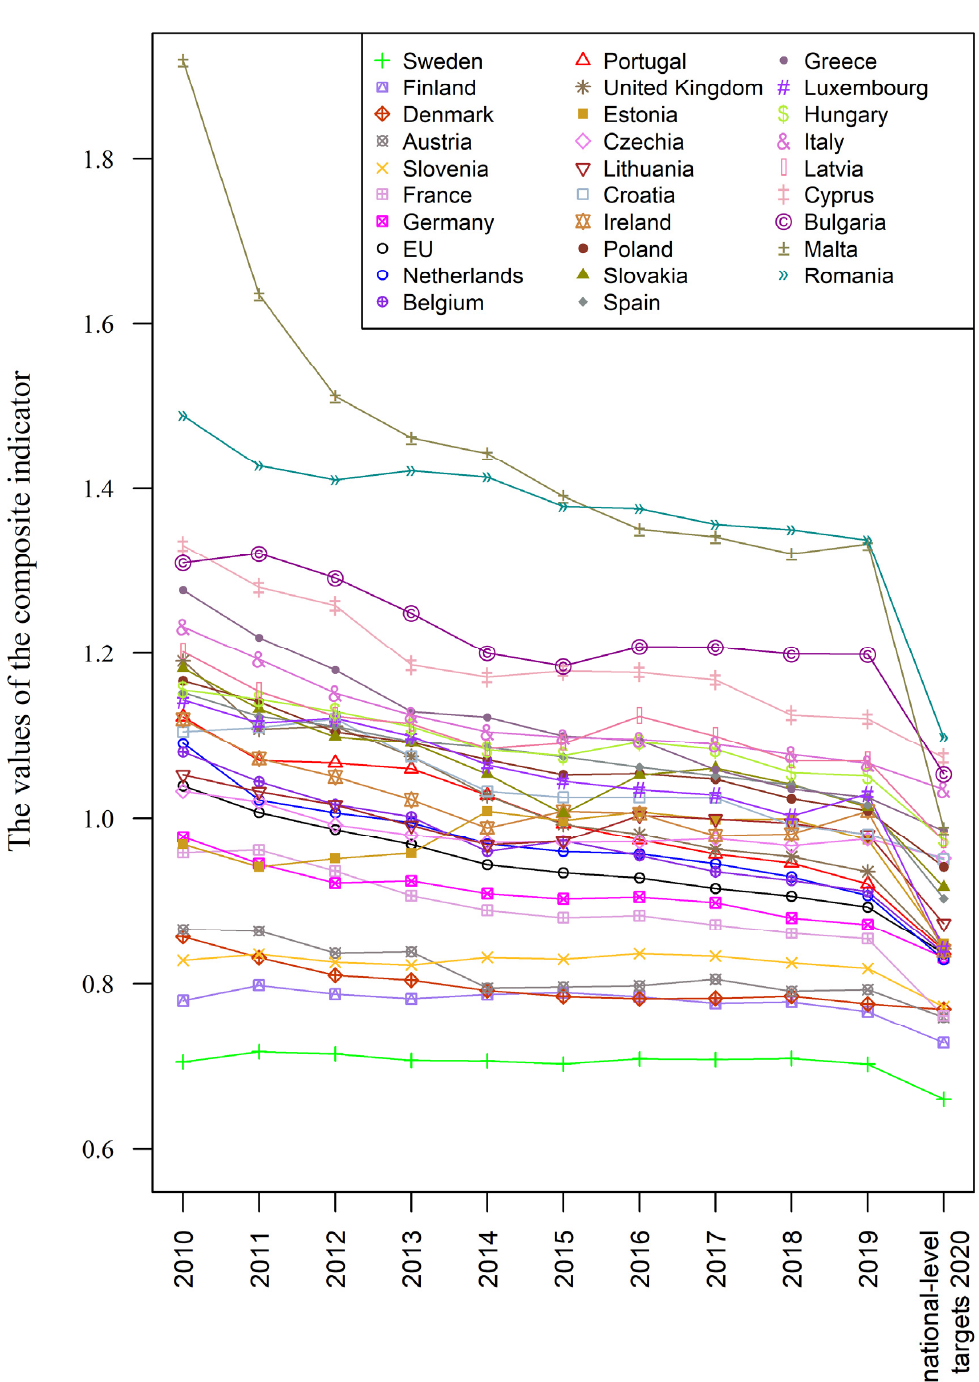
Figure 4. Graphic presentation of the changes in SM it aggregate value for the national-level target analysis, showing changes in the implementation of the EU Strategy from 2010 to 2019, for the European Union countries. Source: authors’